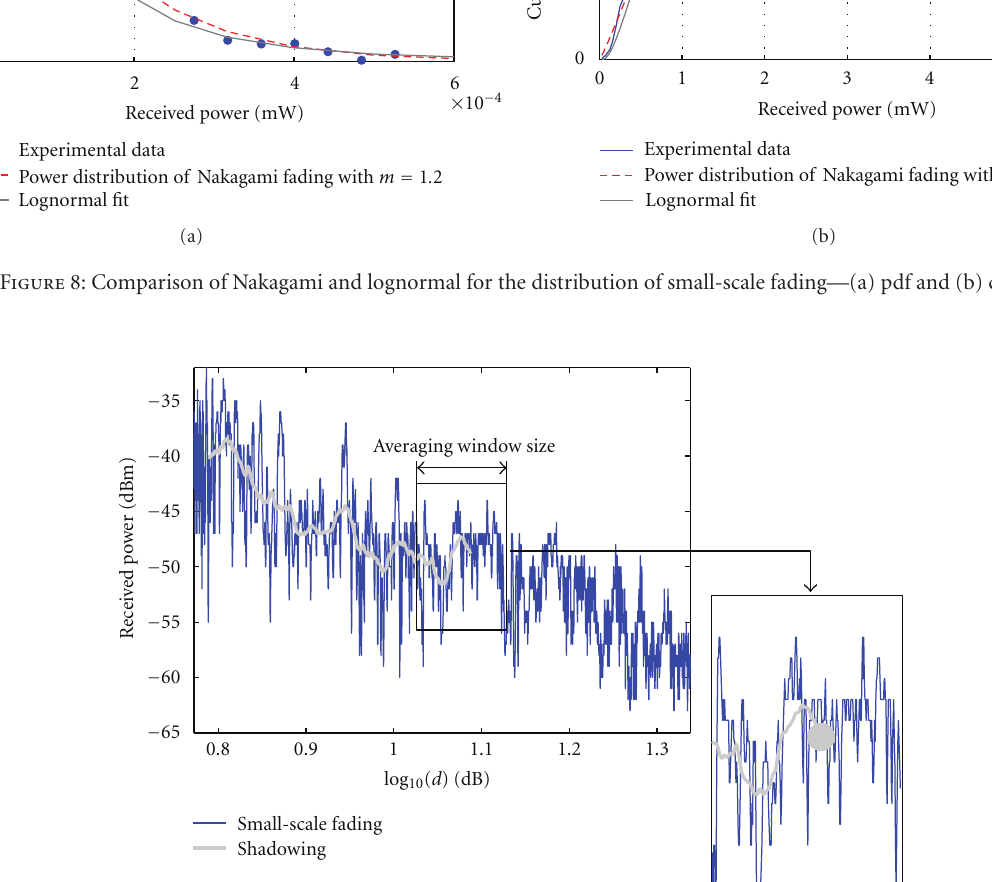
Figure 9: Illustration of moving average over small-scale variations in order to obtain shadowing dynamics. An appropriate window length is chosen such that the small-scale variations can be considered stationary over that length. Then, the value of shadowing at the center of this window corresponds to the average of all the data points within the window. Alternatively, the window size can be adaptive.